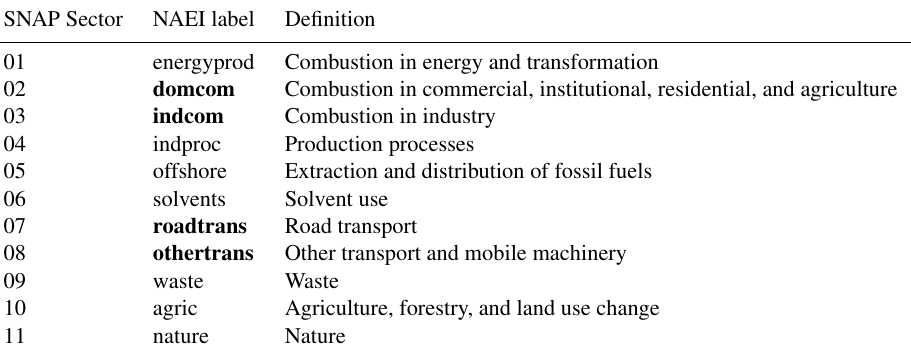
Table A1. SNAP (Selected Nomenclature for sources of Air Pollutants) sector definitions as used in the NAEI Defra and BEIS (2017). The four sectors with the largest contribution to NO x emissions within the footprint of the BT Tower are highlighted in